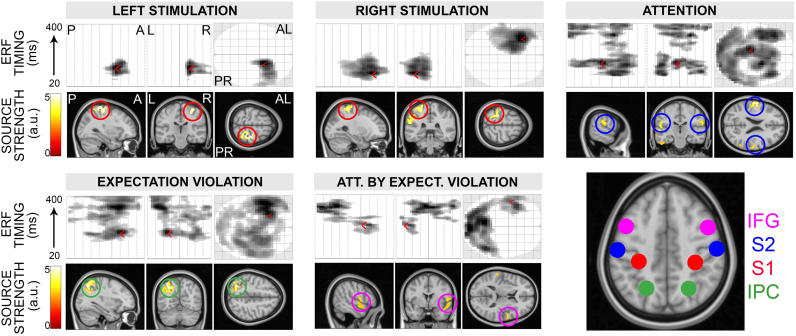
ERF and source reconstruction results. Summary of laterality (separately for left and right), attention, expectation violation main effects, and attention by expectation violation interactions. In each panel, the first row depicts the timing and topography of event-related field effects at the scalp level. The left figure represents the posterior-anterior displacement of the effect as a function of time (y axis, from 20 to 400 ms). The red arrow indicates the ERF maximal peak; e.g., in central-anterior locations, at around 80 ms (left stimulation) and 50 ms (right stimulation) and in a central location at around 100 ms (attention). The central figure represents the left-right displacement as a function of time (y axis, from 20 to 400 ms). Again, the red arrow indicates the ERF maximal peak; e.g., in the right hemisphere (left stimulation), left hemisphere (right stimulation) or close to the midline (attention). Finally, the right figure depicts the topography of the ERF effect at the peak time point; e.g., over anterior right sensors (left stimulation), anterior left sensors (right stimulation), widespread across posterior and anterior sensors (attention). The second row illustrates the topography of reconstructed sources. The analysis identified four bilateral sources (S1, S2, IFG, and IPC). The specific locations of left and right S1 sources (MNI coordinates: left [−26, −36, 58]; right [32, −40, 64]) were derived by comparing right vs. left and left vs. right stimulation (i.e., laterality main effect). We established bilateral S2 coordinates (MNI coordinates: left [−62, 14, 20]; right [62, 24, 26]) by comparing attended vs. unattended pain, regardless the stimulation side. Finally, we identified left inferior frontal and right inferior parietal regions (MNI coordinates: left IFG [−54, 8, 16]; right IPC [36, −66, 40]) in the expectation violation main effect, as well as right inferior frontal and left inferior parietal regions (MNI coordinates: right IFG [54, 0, 10]; left IPC [−32, −64, 46]) in the attention by expectation violation interaction. The identified sources were then entered into a dynamic causal modelling specifying alternative connectivity architectures. (For interpretation of the references to color in this figure legend, the reader is referred to the web version of this article.)